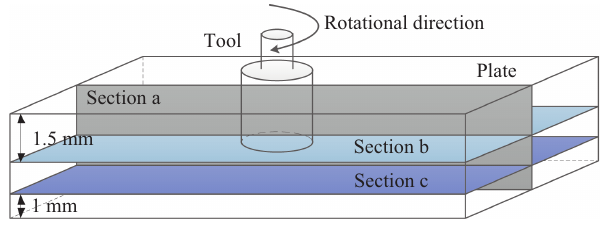
Figure 5: Positions of different sections.